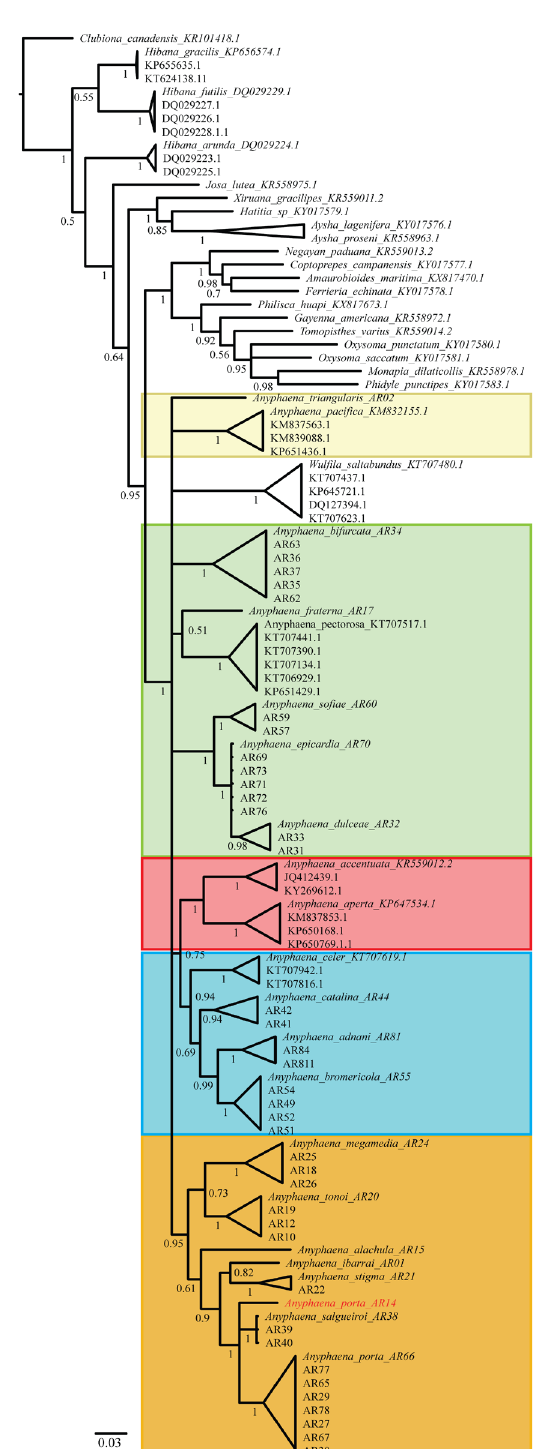
Fig. 54. Tree topology obtained with Bayesian Inference in MrBayes. Colored boxes indicate groups of Anyphaena : pacifica (gold), accentuata (red), celer (blue), pectorosa (green) and porta (ochre). Numbers in the nodes indicate posterior probabilities. Support values under 50 are collapsed. Note that most of the deeper relations within the Anyphaena+Wulfila clade are not resolved, especially for the pacifica and pectorosa groups. The accentuata+celer and the porta groups are recovered as monophyletic clades with moderate to high